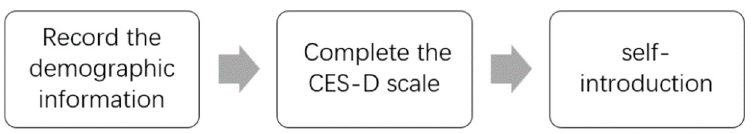
Figure 1. The overall process of the experiment.